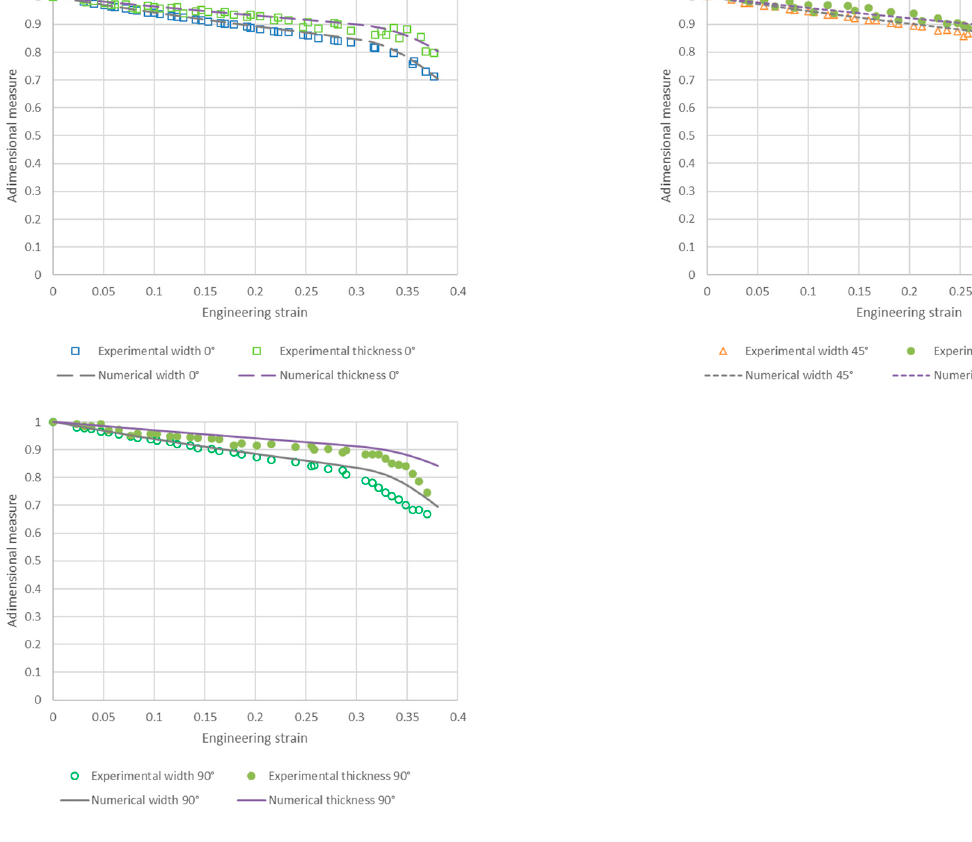
Figure 4. Experimental and numerical width and thickness ratios as a function of the engineering strain for tensile specimens of the EK4 steel oriented at 0°, 45° and 90° with respect to the rolling direction.